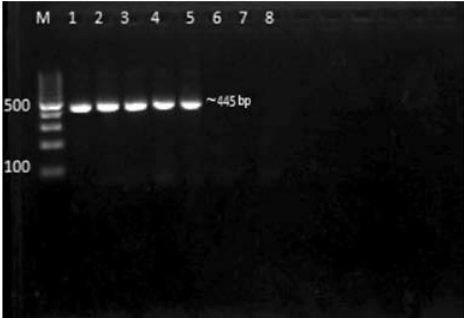
Fig. 1 Detection of MTBC using IS 6110 specific PCR (Representation) Lane M- 100 bp Molecular marker L 1: Positive control L 2-5: Positive samples Lane 6,7: Negative samples Lane 8: no-template control